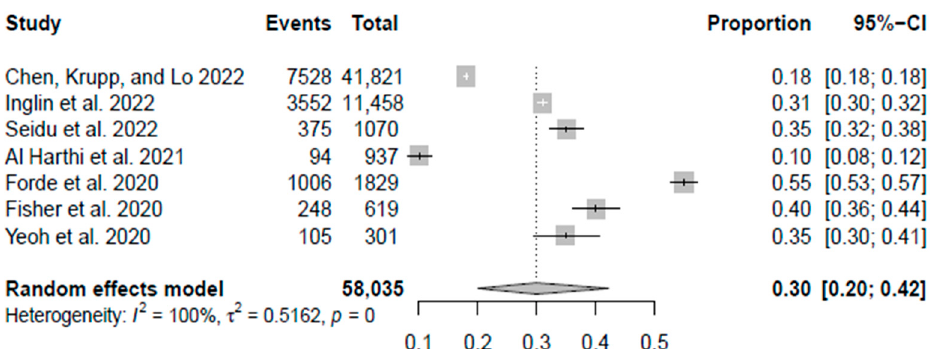
Figure 2. A forest plot of meta-analysis shows the surge in telemedicine usage among T2DM patients during the COVID-19 pandemic. (Chen, Krupp, and Lo 2022 [38], Inglin et al., 2022 [39], Seidu et al., 2022 [41], Al Harthi et al., 2021 [43], Forde et al., 2020 [49], Fisher et al., 2020 [50], and Yeoh et al., 2020 [51].